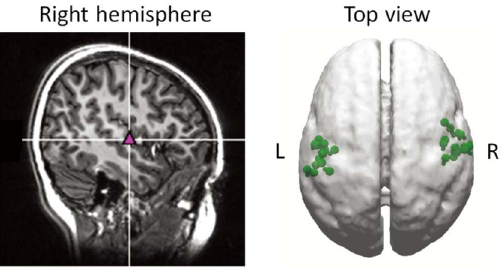
Figure 3. Locations of N100m sources to cue sounds. (a) Typical example of N100m source location superimposed on the anatomical image of one subject. (b) Distribution of the source locations of all participants superimposed on a top view of a template brain.